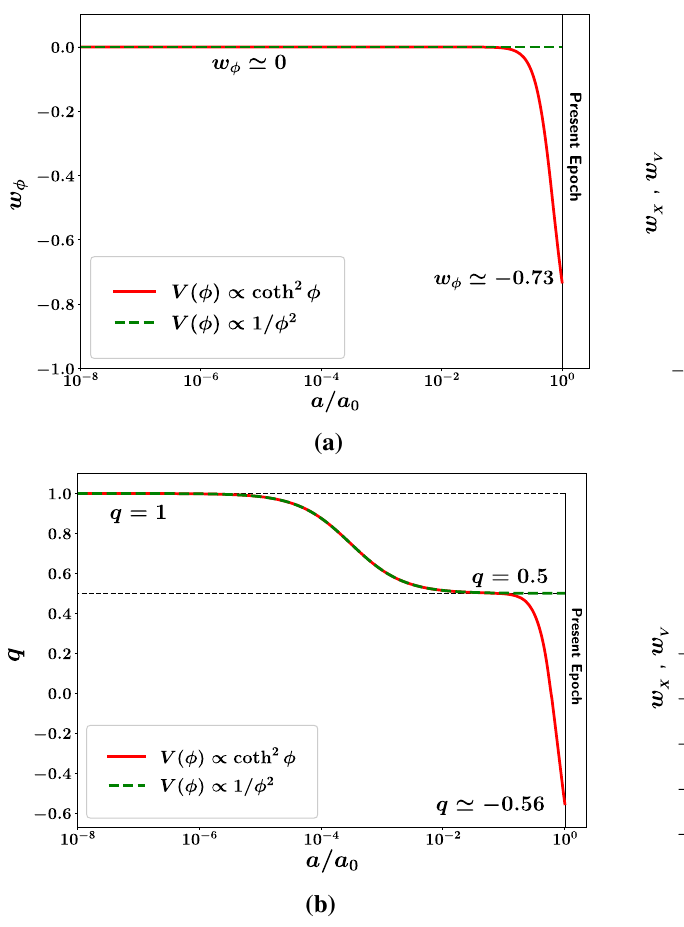
Fig. 4 The equation of state w φ and the deceleration parameter q are shown in the top and bottom panels respectively for the potentials (cid:7) (cid:8) φ V (φ) = V 0 coth 2 (solid red) and V (φ) = V 0 m p green). From a one finds that w φ in both models remains pegged at w φ (cid:2) 0 for z > ∼ 10. For z < 10 the EOS remains unchanged in IPL but declines to negative values in the coth potential. This is substantiated by b which shows that the deceleration parameter in both models remains the same until z ∼ 10. Thereafter q declines to negative values at late times for the coth potential (red curve), reflecting the late-time acceler- ation of the universe. For the IPL potential on the other hand (dashed green) the universe stays matter dominated at late times ( q (cid:2) 0 . 5) and does not accelerate